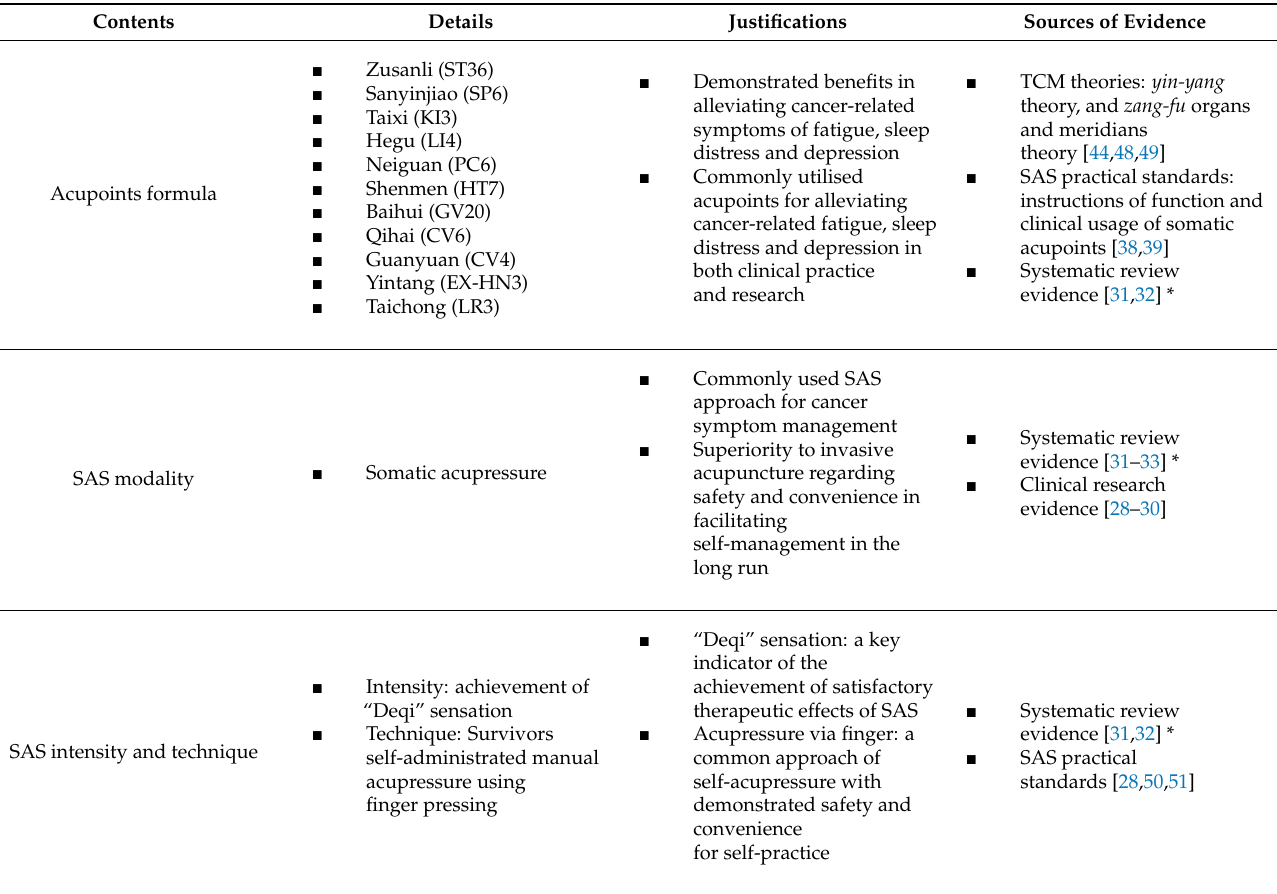
Table 1. Contents of the true SAS intervention protocol with relevant justifications and